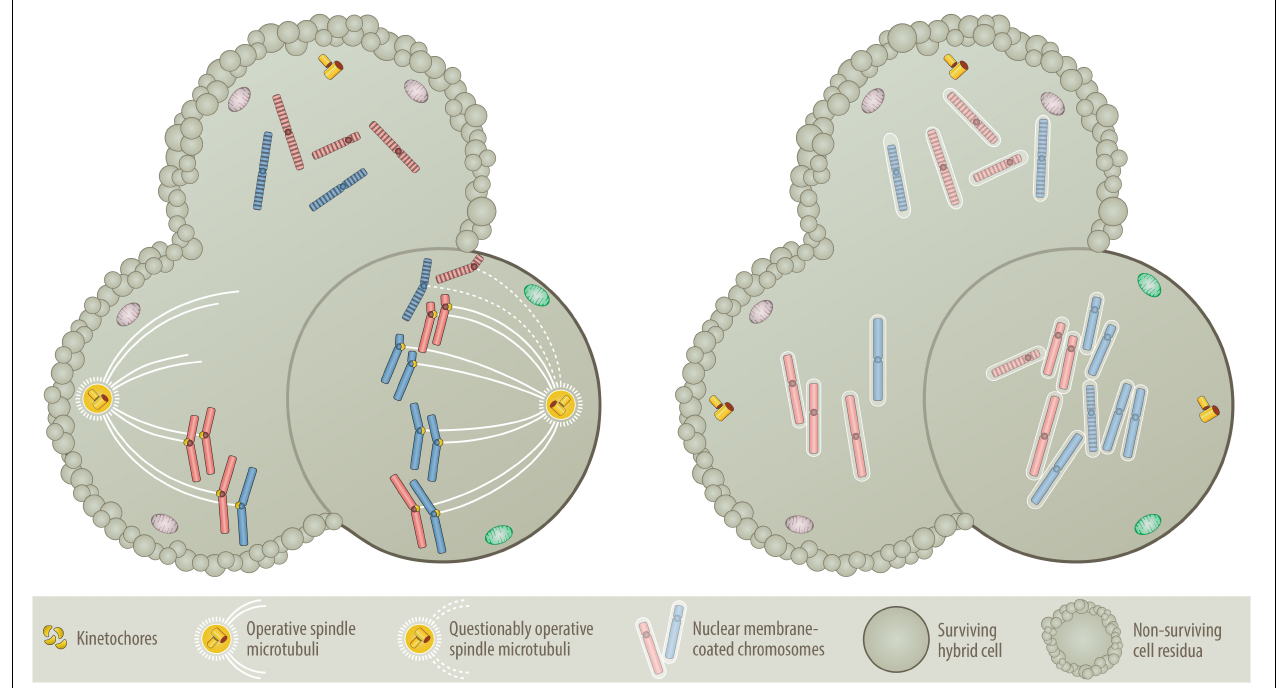
FIGURE 4 | Nondisjunction (Left) versus “micronuclei” fusion (Right) versions of aneuploidy formation. One of the central questions of the BNDA model is whether at all and how prematurely condensed G0/G1 chromosomes can be incorporated into the mitotic chromosome cluster. As illustrated on the left,